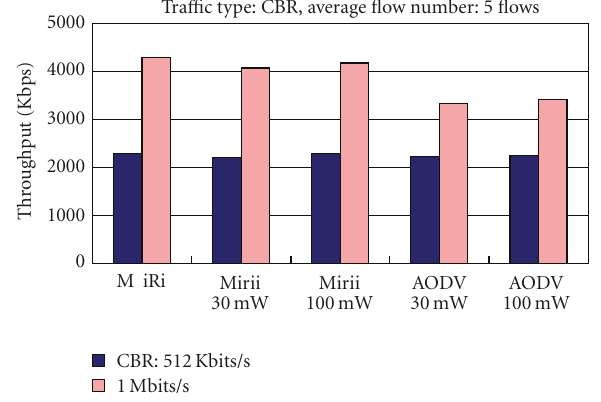
Figure 10: Throughput of di ff erent tra ffi c load in a random network topology with gateway.